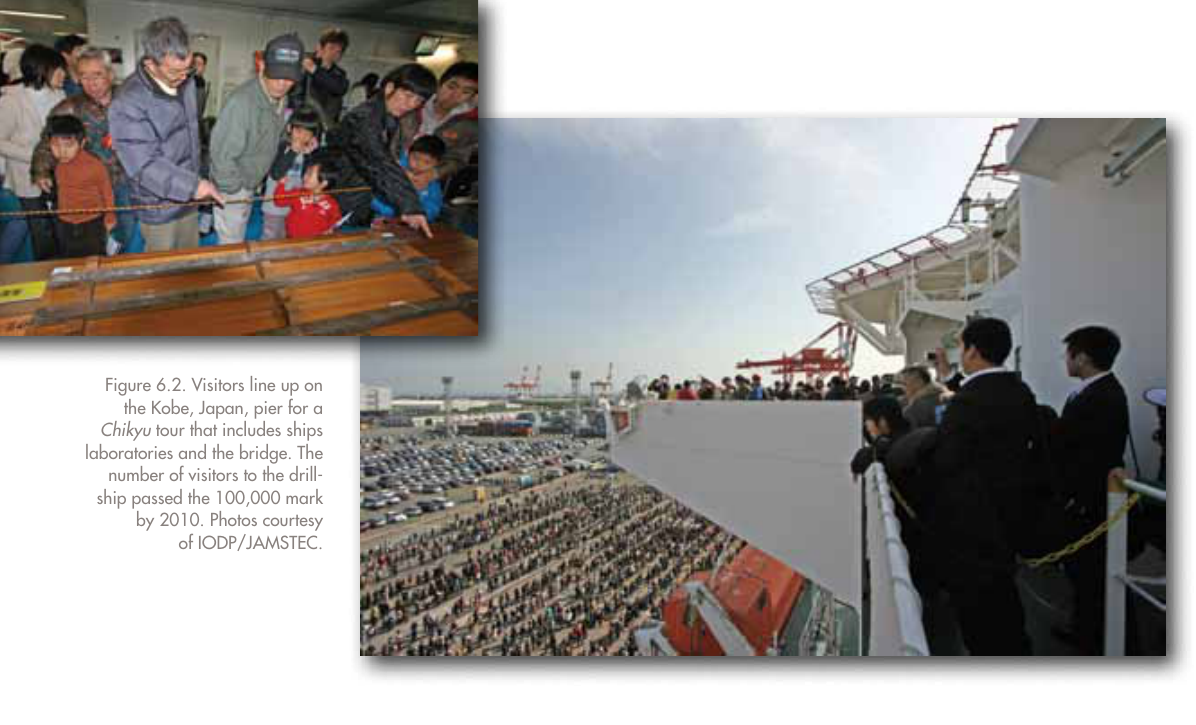
figure 6.2. visitors line up on the Kobe, Japan, pier for a Chikyu tour that includes ships laboratories and the bridge. The number of visitors to the drill- ship passed the 100,000 mark by 2010. photos courtesy of